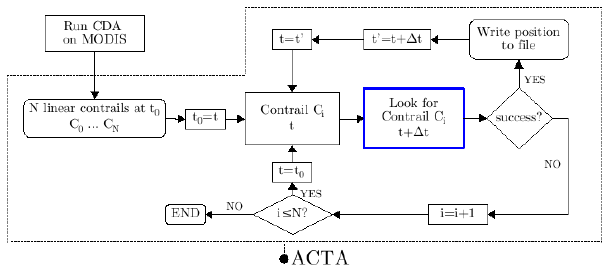
Figure 2. Schematic representation of ACTA. Input: list of linear contrails detected by the CDA on MODIS (Vázquez-Navarro et al.,